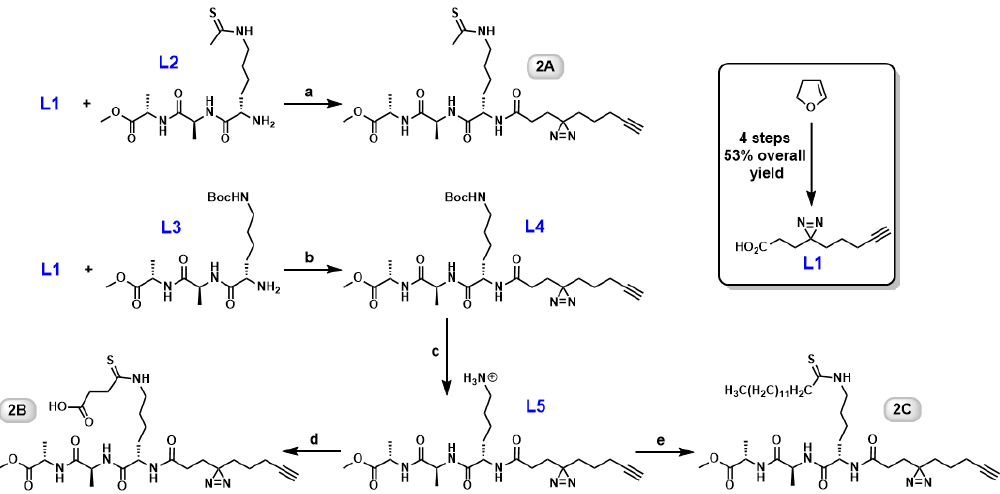
Figure 2 . Synthesis of diazirine-based ABPs. a. PyBOP, DIPEA, DMF (85%); b. PyBOP, DIPEA, DMF (81%); c. TFA, tri- Figure 2. Synthesis of diazirine-based ABPs. a . PyBOP, DIPEA, DMF (85%); b . PyBOP, DIPEA, DMF (81%); c . TFA, ethylsilane, CH 2 Cl 2 (quantitatively); d. tert-butyl thiophenyl mono-thiosuccinate, 5% Na 2 CO 3 , MeOH, 0 °C to r.t. (83%); e . triethylsilane, CH 2 Cl 2 (quantitatively); d . tert-butyl thiophenyl mono-thiosuccinate, 5% Na 2 CO 3 , MeOH, 0 ◦ C to r.t. (83%); thiophenyl thiomyristate, 5% Na 2 CO 3 , MeOH, 0 °C to r.t. (91%). e . thiophenyl thiomyristate, 5% Na 2 CO 3 , MeOH, 0 ◦ C to r.t.